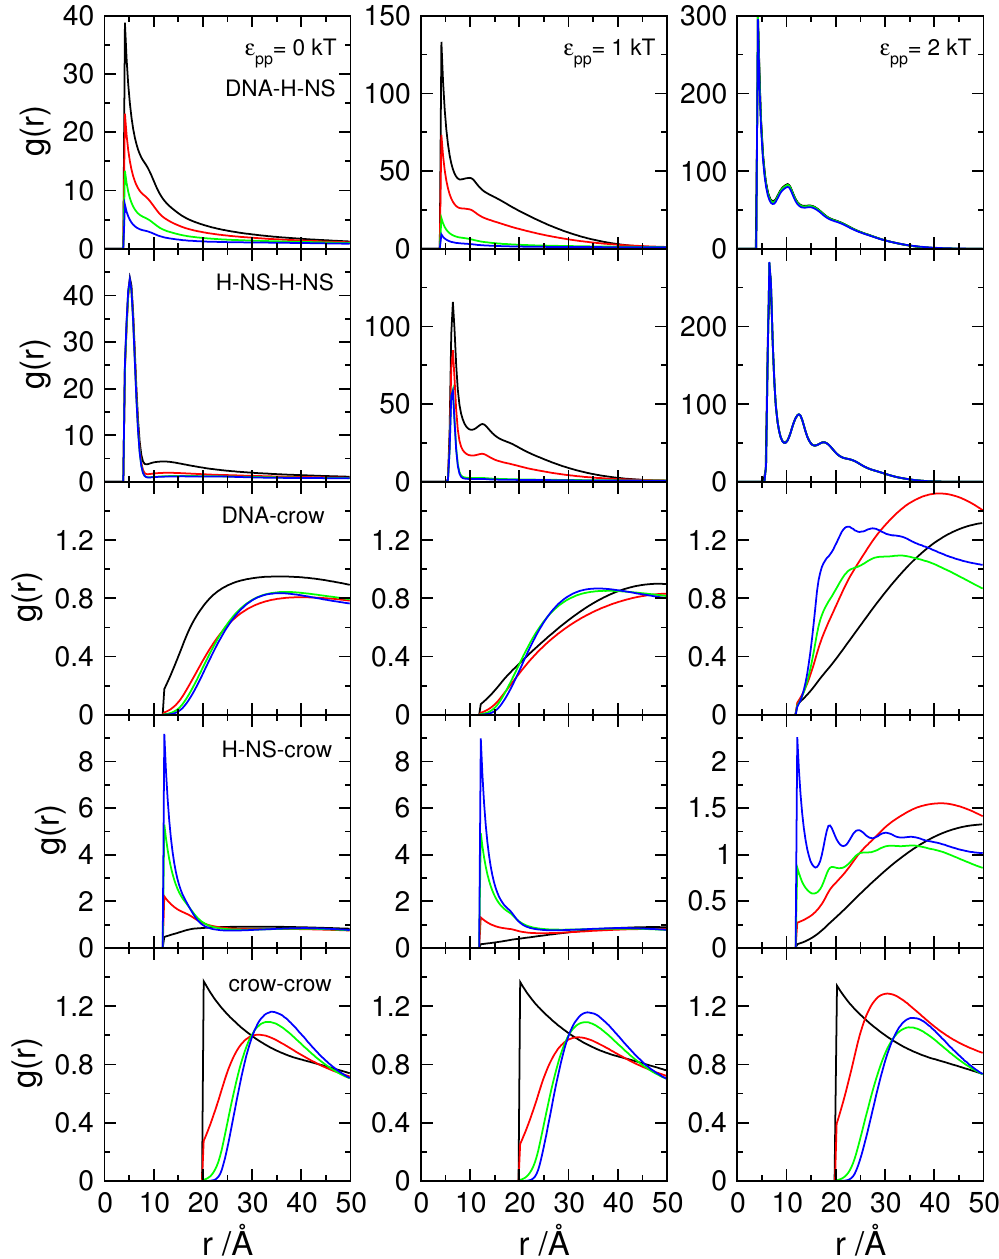
Figure 9. Radial distribution functions, rdf, of (from top to bottom) DNA–H-NS monomers, H-NS–H-NS monomer, DNA monomer–crowding agents, H-NS monomers–crowding particles, and crowding–crowding particles, as indicated in the panels on the left, for protein self-association potential, ε pp , of (from the left to the righ-hand-side) 0, 1, and 2 kT (as indicated in the top panels). Φ crow = 0.06 and σ crow = 0 (black), − 0.40 (red), − 0.80 (green) and − 1.20 (blue) e /nm 2